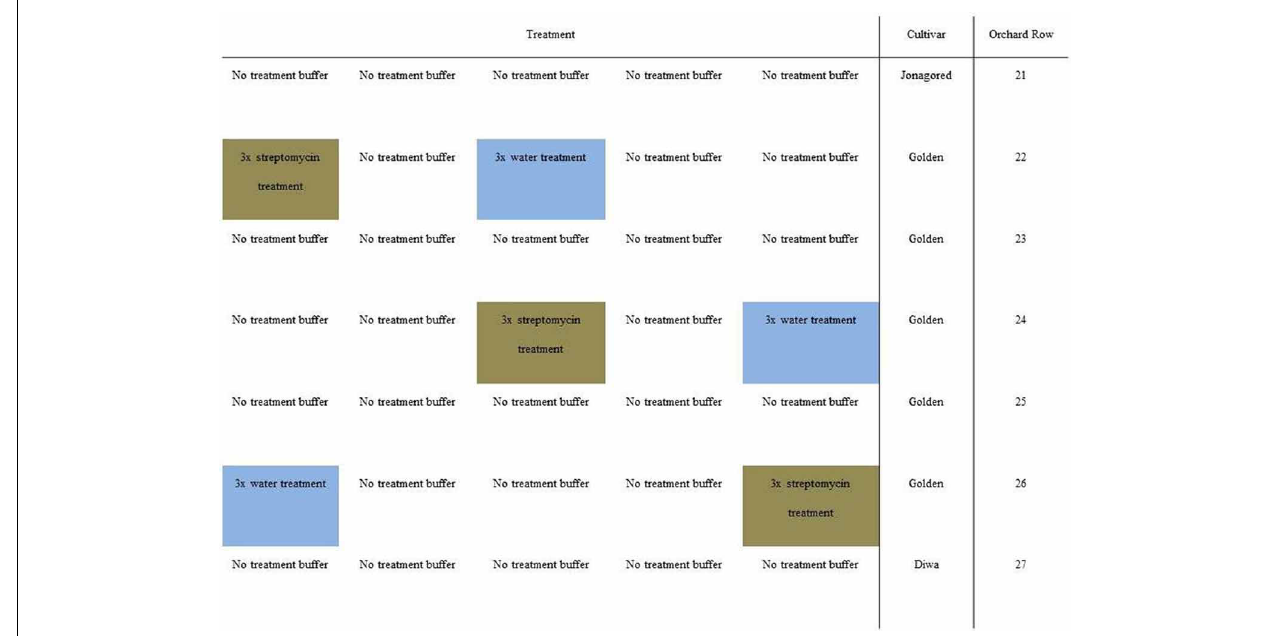
FIGURE 1 | Schematic diagram of the three orchard sites and streptomycin or water spraying strategies.